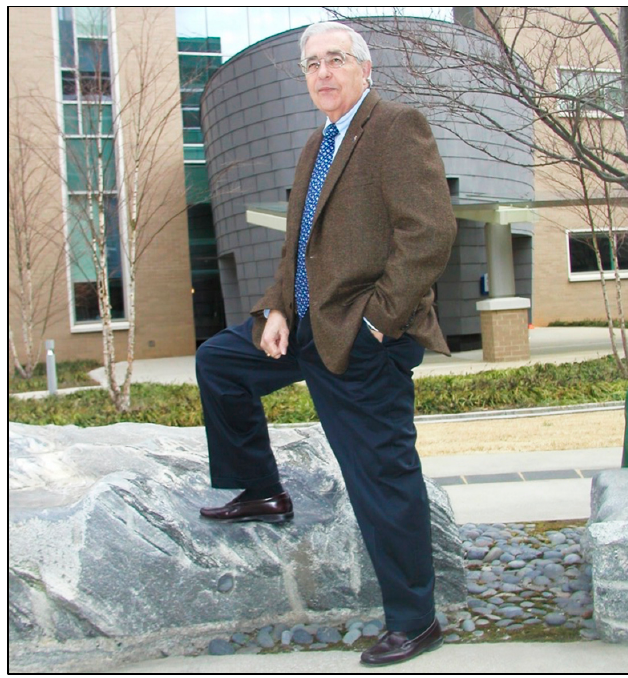
Figure 1. Dr. William Harry Hannon (Provided by Hannon family friend). He was preceded in death by his beloved wife, Barbara Cheryl Hannon (Cherry). In retirement, Harry enjoyed spending time with his children and grandchildren. He continued his work in the field of public health newborn screening (NBS), initiating, ex- panding, and improving NBS worldwide.